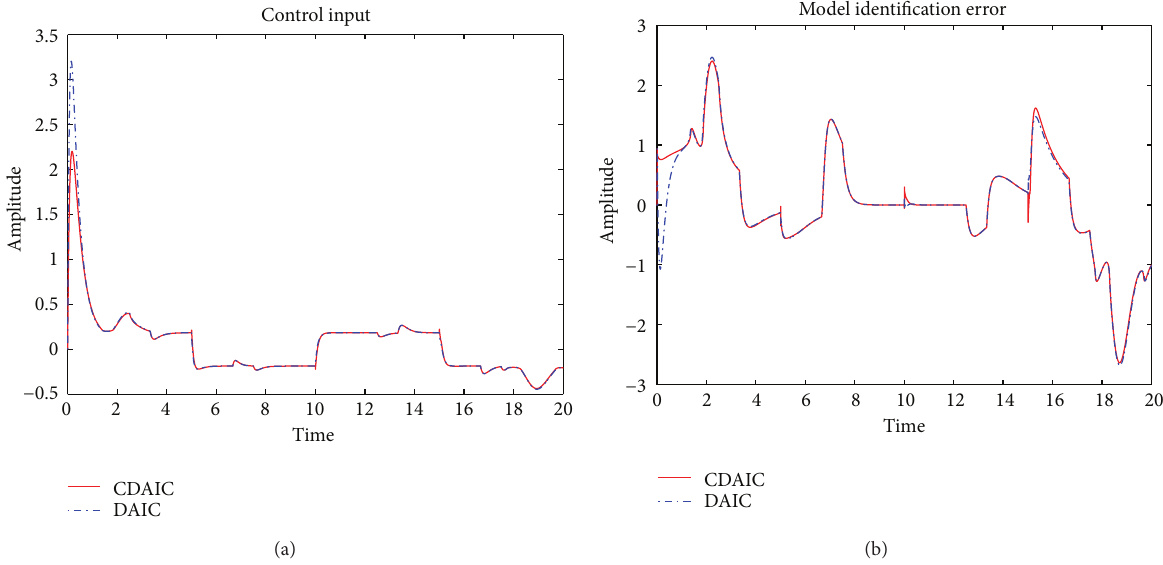
Figure 7: Example 2: simulation results: (a) control input; (b) model identification